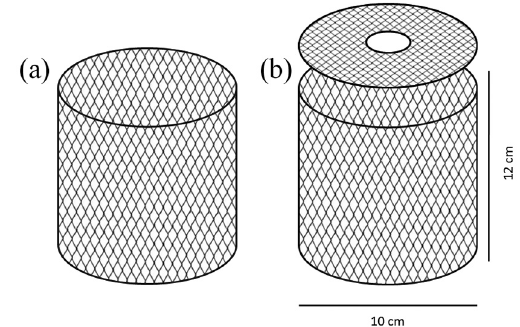
Figure 2: Schematic representation of (a) Active Screen Partial System, (b) Active Screen System. pressure of the chamber was 0.0013 Pa. The substrates